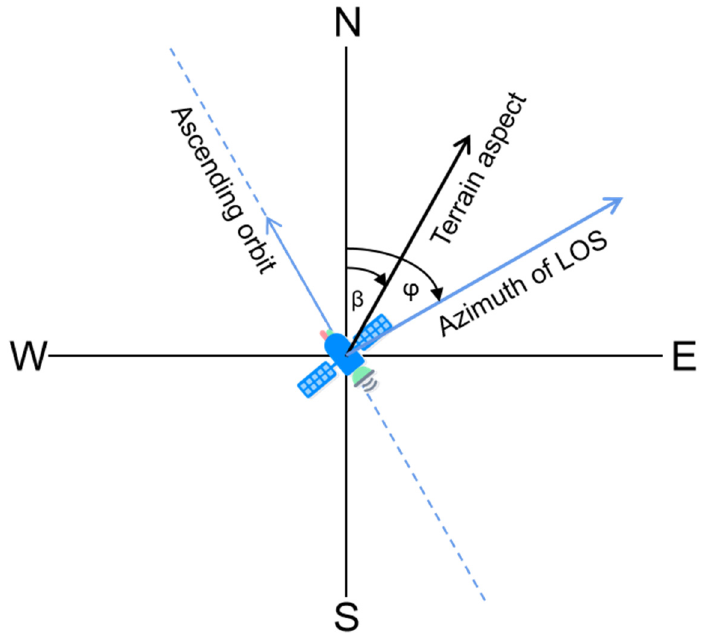
Figure 5. A schematic diagram of the triangle of satellite and ground observations.